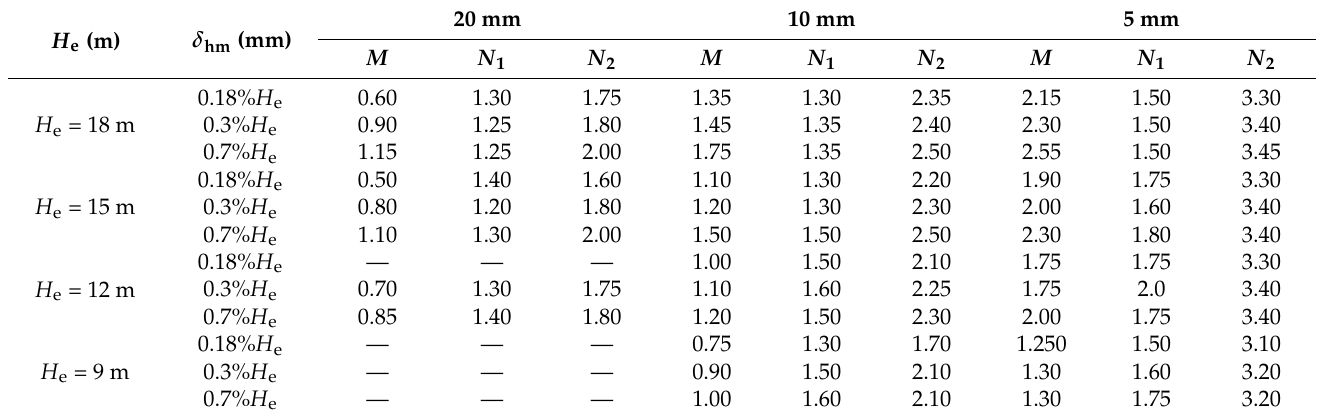
Table 3. Determination parameters of influenced zones under different simulation conditions.